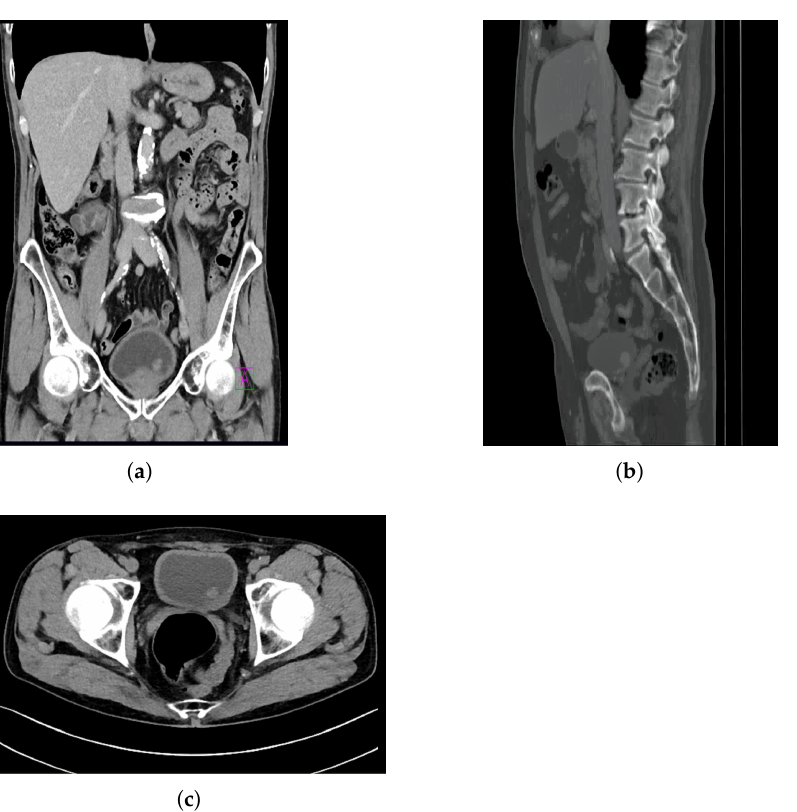
Figure 2. Examples of images contained in the dataset: ( a ) frontal plane; ( b ) sagittal plane; and ( c ) axial